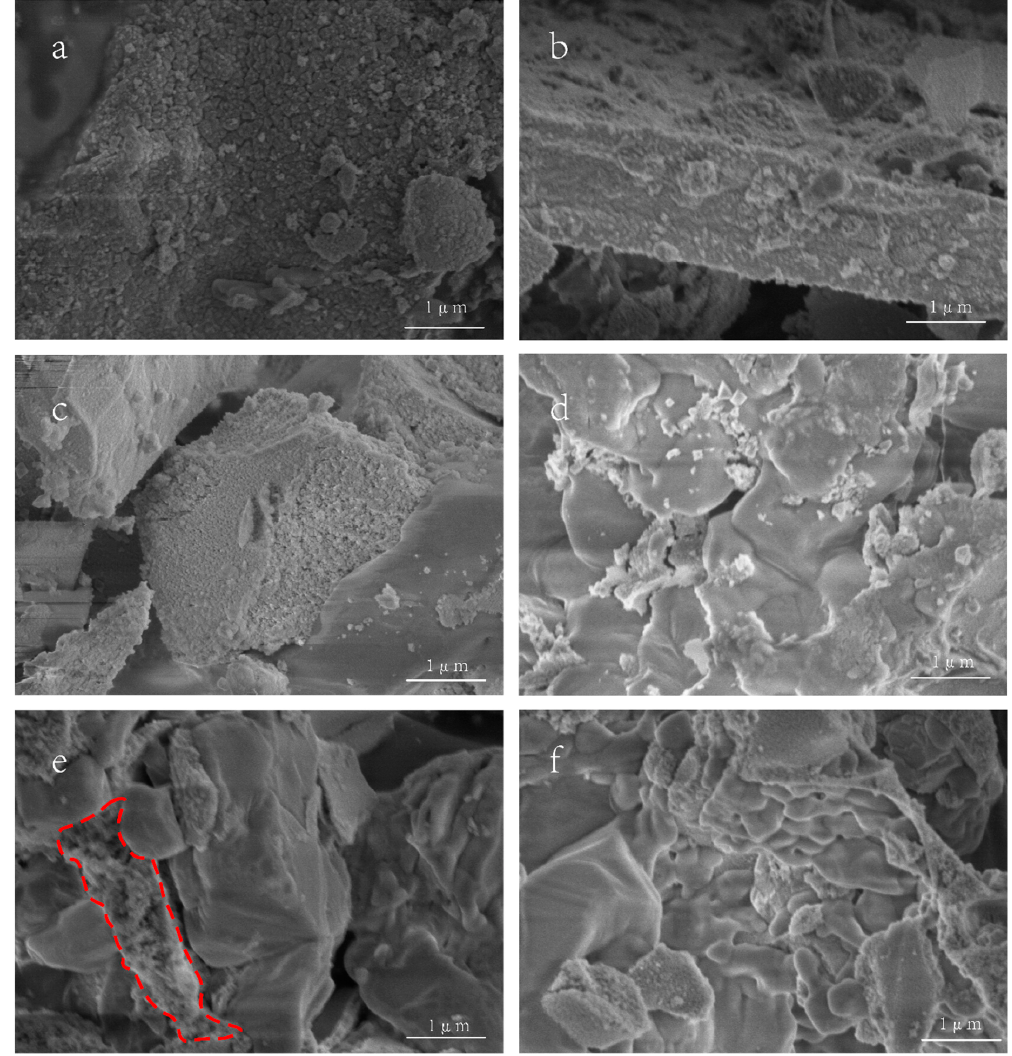
Figure 1. SEM morphologies of the catalysts ( a ) CZ, ( b ) Co/CZ, ( c ) ZC, ( d ) Co/ZC, ( e ) K/ZC, ( f )